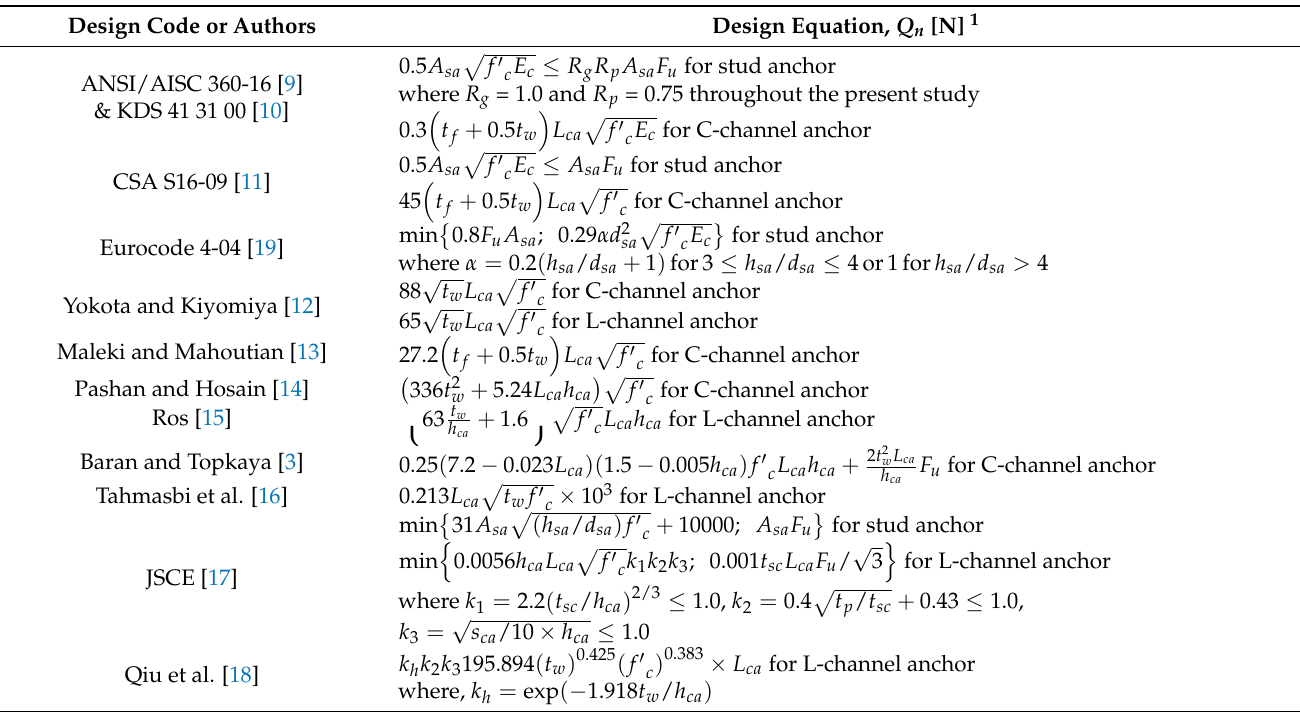
Table 4. Existing Design Equations for Stud Anchors and Channel Anchors with Full-length